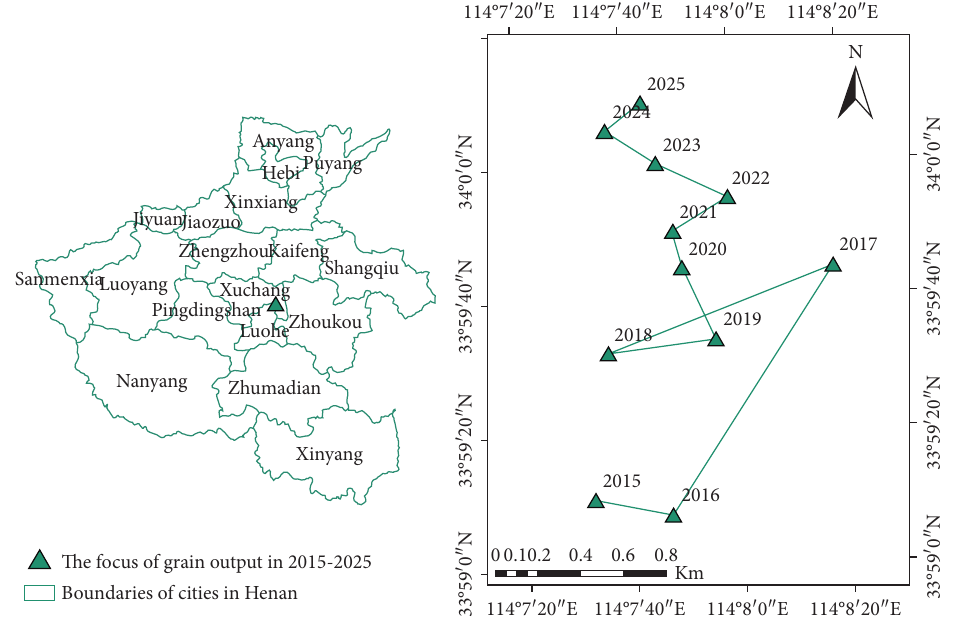
Figure 9: Changes of grain yield gravity center track in Henan province from 2015 to 2025.